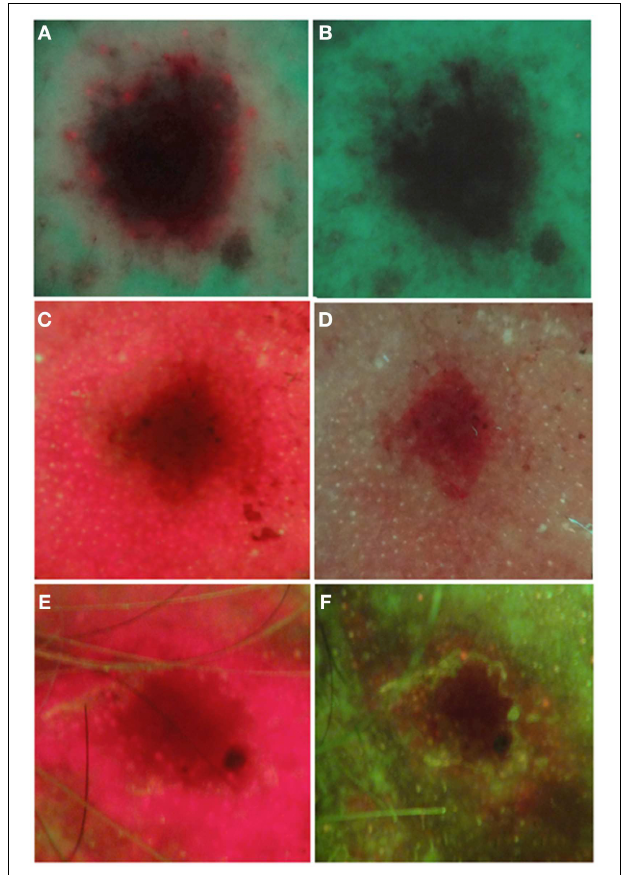
FIGURE 2 | PpIX fluorescence images of BCC lesions after 3h of MAL topical application (A,C,E) and after the first PDT session